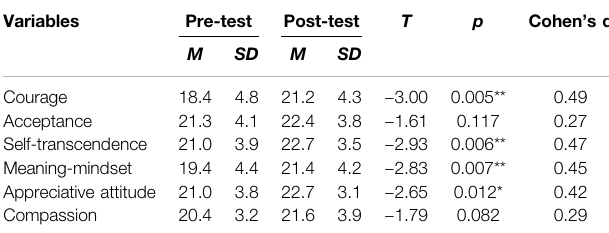
TABLE 3 | Table of t -test statistics for paired samples of the CasMac pre-test and post-test. Variables